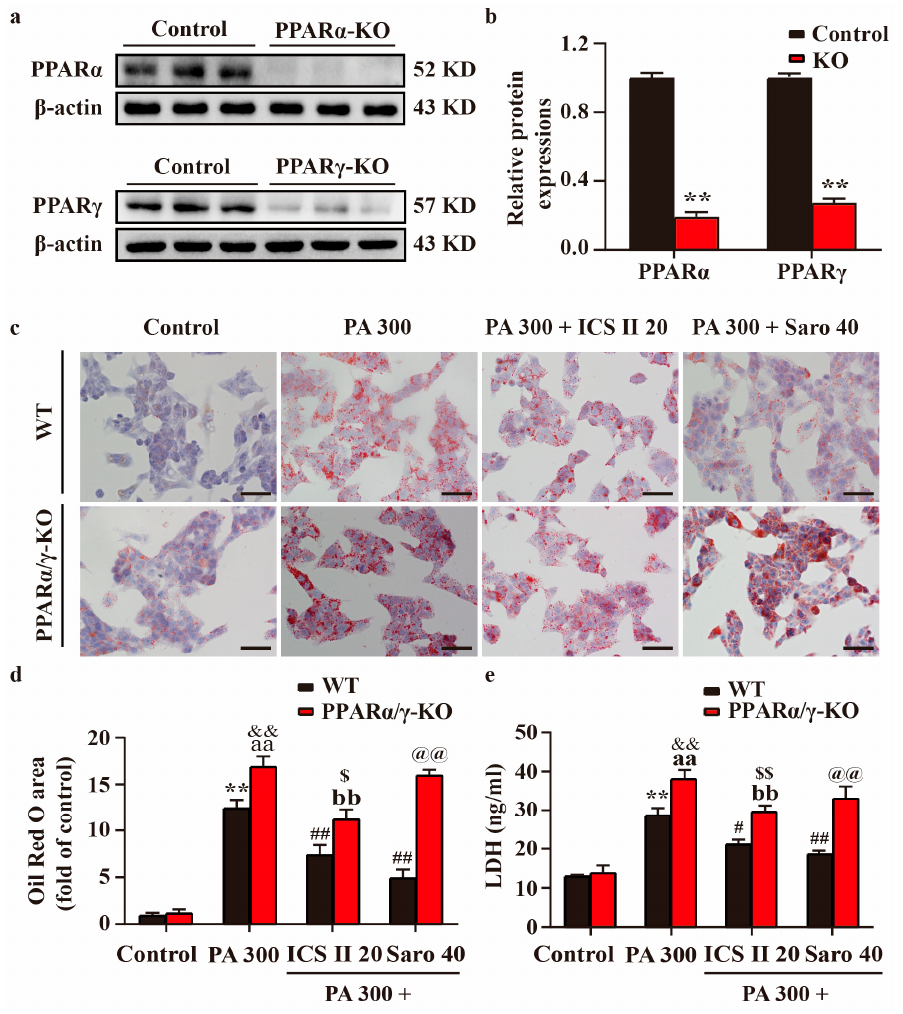
Figure 10. Effect of ICS II on PA-induced injury in PPAR α / γ -KO HepG2 cells. ( a ) Representative western blot of PPAR α and PPAR γ protein expressions after knockout of PPAR α / γ . ( b ) Quantitation of PPAR α / γ protein expressions ( n = 6). ( c ) Oil red O staining of HepG2 cells ( × 400, scale bar = 50 µ m). Treatment with or without ICS II (20 µ M) in PPAR α / γ -KO HepG2 cells and WT HepG2 cells. ( d ) Quantitation of Oil red O staining ( n = 5). ( e ) LDH level. Treatment with or without ICS II (20 µ M) in PPAR α / γ -KO HepG2 cells and WT HepG2 cells. ( n = 6). Data were expressed as mean ± SEM. ** p < 0.01 versus control group (WT); # p < 0.05 and ## p < 0.01 versus PA 300 group (WT); aa p < 0.01 versus control group (PPAR α / γ -KO); bb p < 0.01 versus PA 300 group (PPAR α / γ -KO); && p < 0.01 versus PA 300 group (WT); $ P < 0.05 and $$ p < 0.01 versus PA 300 + ICS II 20 group (WT); @@ p < 0.01 versus PA 300 + Saro 40 group (WT).